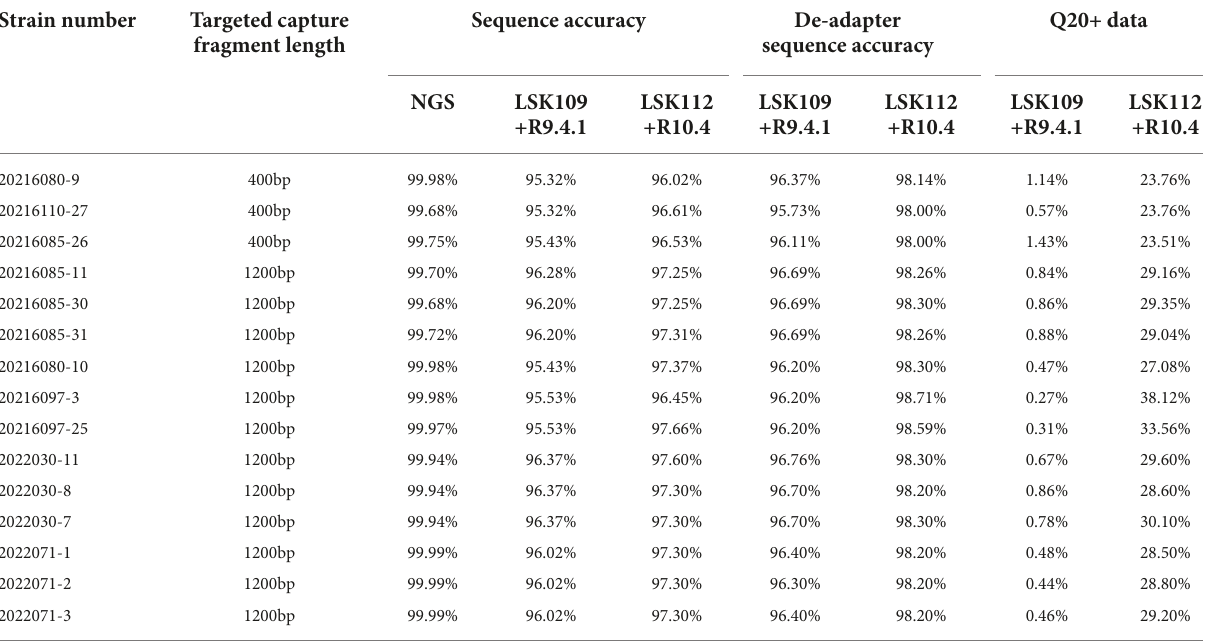
TABLE 4 The accuracy of whole genome sequencing of 15